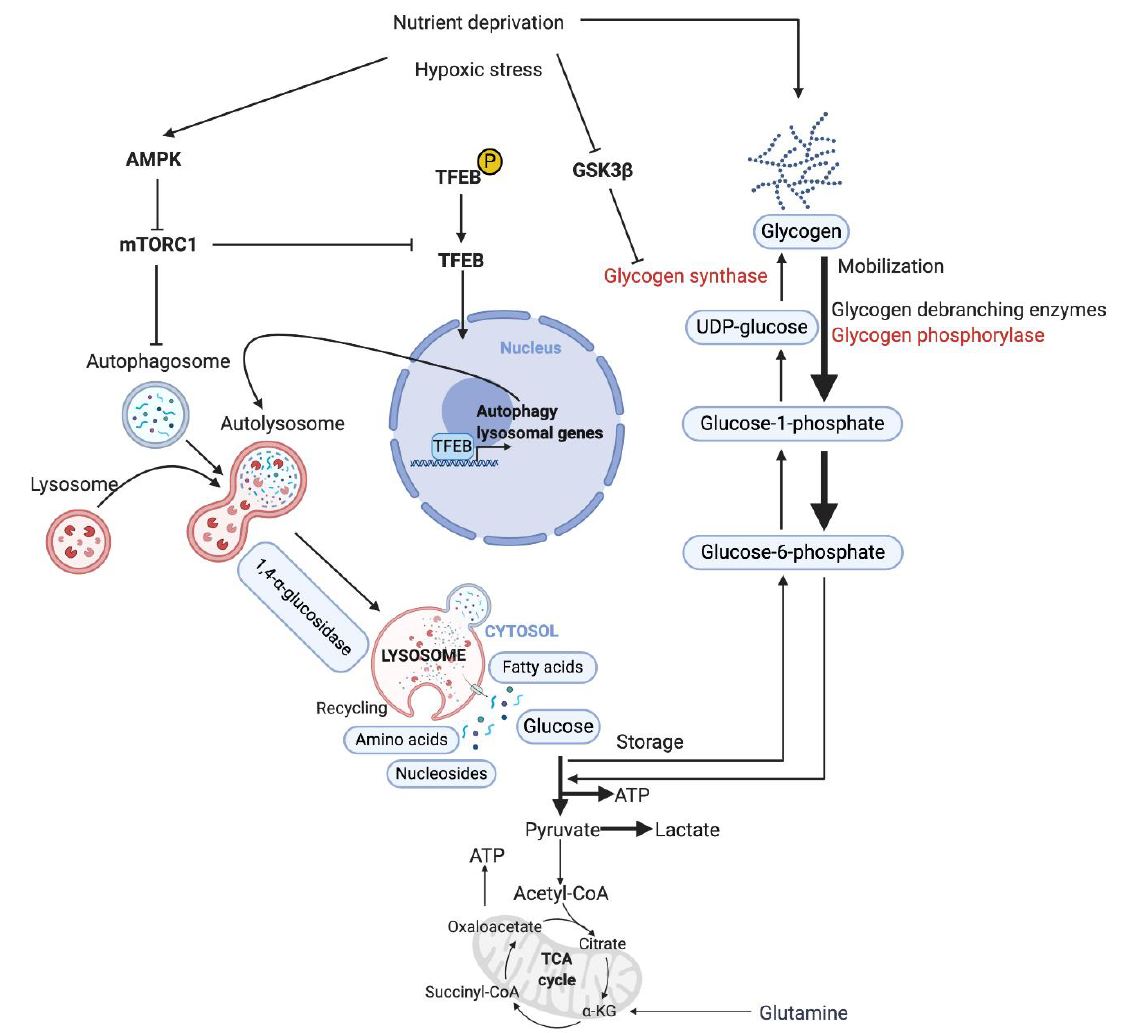
Figure 4. EC glucose and glycogen metabolism in hypoxia and nutrient-deprivation conditions. Under hypoxia and nutrient-deprivation conditions, cellular energy levels are decreased and autophagy is upregulated by the AMPK–mTORC1 pathway. The autophagy–lysosomal pathway promotes the recycling of nutrients, including glucose, for cell survival. In response to environmental changes, ECs use glycogen as a backup energy source. Upon nutrient deprivation, TFEB translocates to the cell nucleus, where it activates target genes involved in lysosomal function and autophagy. Upregulated autophagy/lysosomal activity supports ECs to resist the detrimental effects of hypoxia and nutrient deprivation. Red color represents the key metabolic genes.